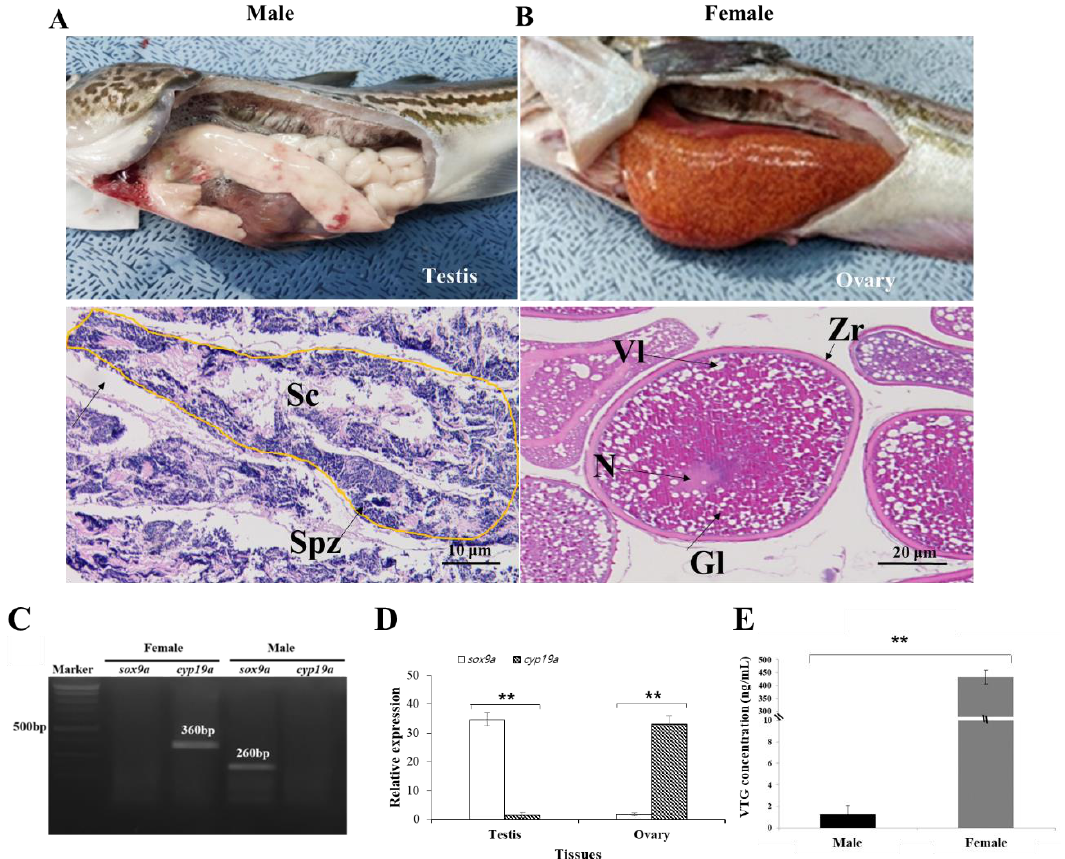
Figure 2. ( A ) Analysis of the gonadal tissues from mature males and their histological analyses; Spz indicates spermatozoa, Sc indicates spermatocysts (yellow), and the arrows represent empty spaces after spermatozoa removal; ( B ) Analysis of the gonadal tissues from mature females and their histological analyses. N indicates nucleus, Zr indicates zona radiata, Gl indicates yolk globules, and Vl indicates vacuoles; ( C ) Analysis of sox9a (260 bp) and cyp19a (360 bp) expression in mature male and female gonadal tissues; the results were confirmed by 1.2% agarose gel. The DNA marker used was 100 bp Plus DNA Ladder (Bioneer, Korea). ( D ) The relative mRNA expression levels of sox9a and cyp19a in aldult male and female gonadal tissues. The expression of each sample was relative quantity to the expression of 18s rRNA Values are reported as mean ± SD of the three experiments; ( E ) VTG levels in mature male and female blood (by ELISA). * indicates P < 0.05, ** indicates P < 0.01.